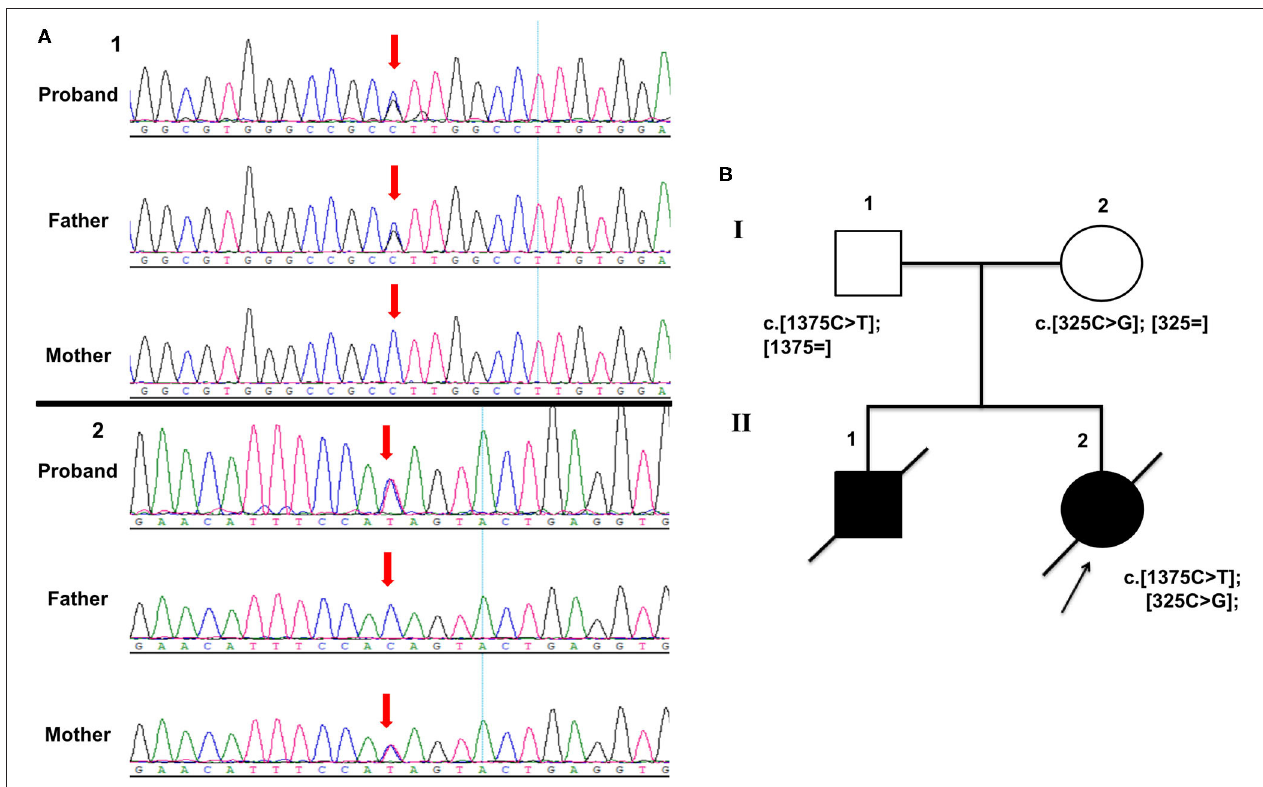
FIGURE 2 | (A) Sanger sequencing electropherograms showing compound heterozygous variants in MOCS3 ( A showing c.1375C > T and B showing c.325C > G). (B) Pedigree chart of the